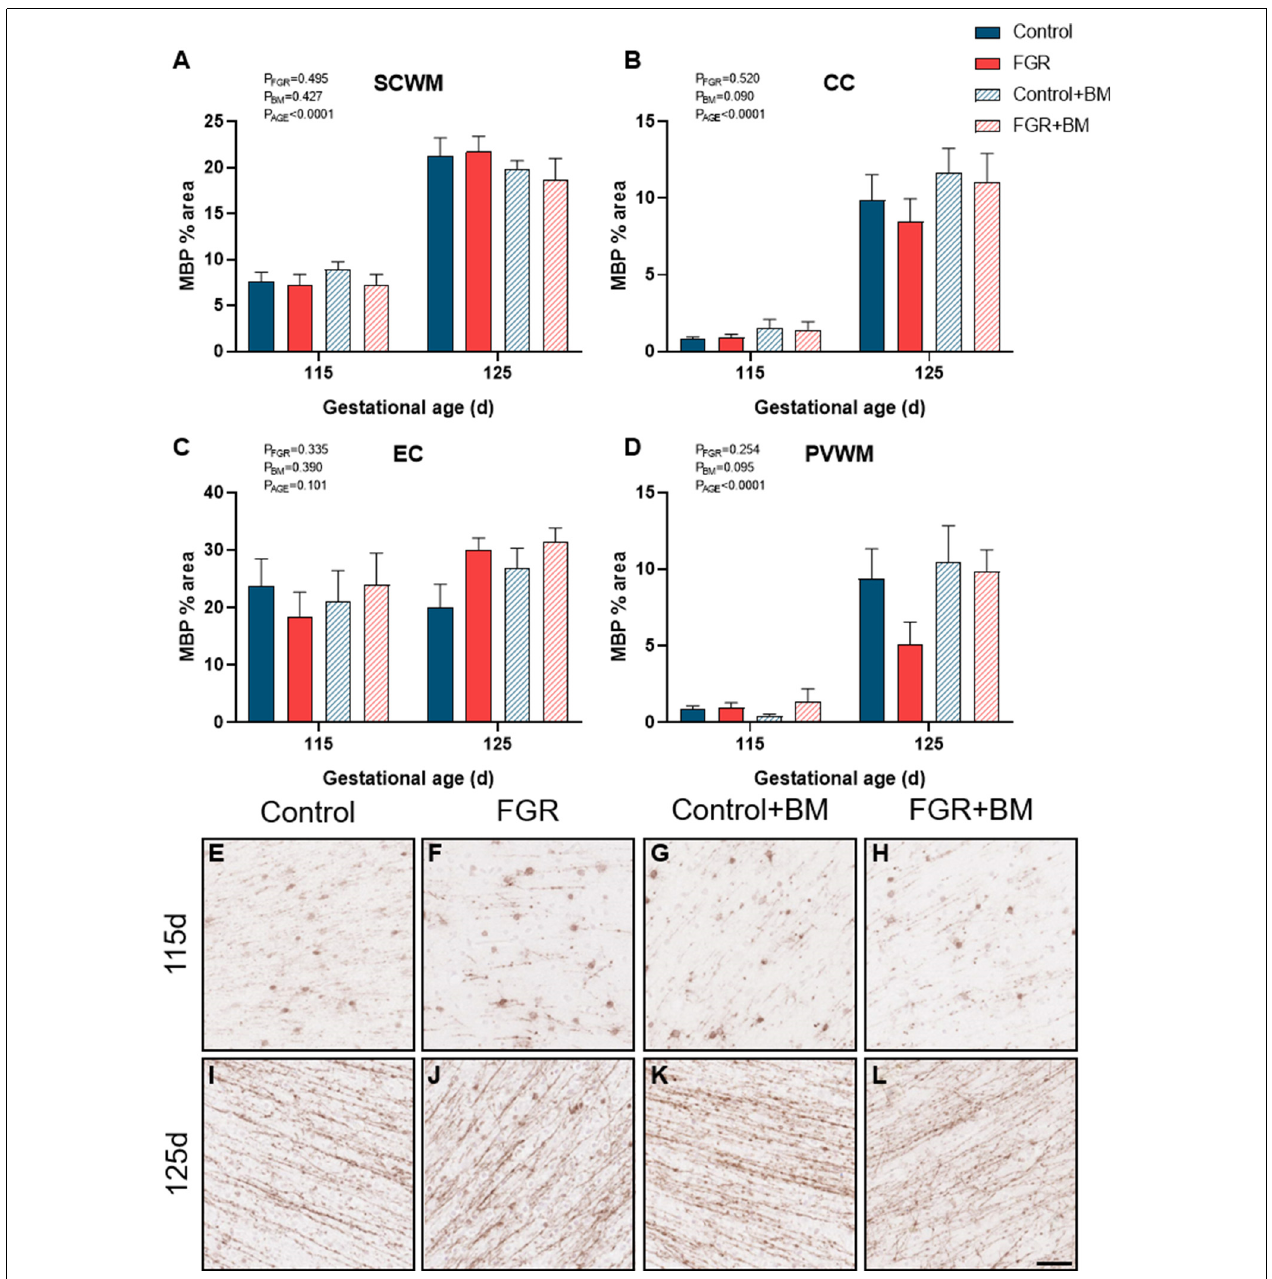
FIGURE 4 | MBP immunoreactivity. The % area of MBP positive staining in the SCWM (A) , CC (B) , EC (C) and PVWM (D) and photomicrographs of the SCWM from 115 days control (E) , FGR (F) , control+BM (G) , FGR+BM (H) and 125 days control (I) , FGR (J) , control+BM (K) and FGR+BM (L) fetuses. Data are presented as mean ± SEM, scale bar = 50 µ